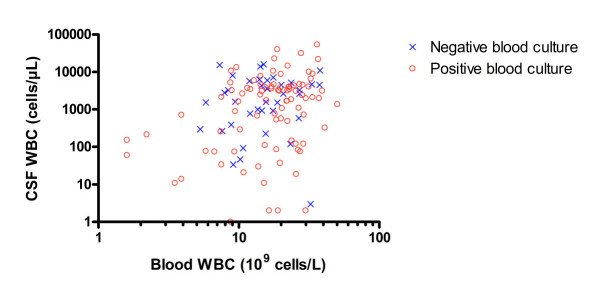
Correspondent CSF and blood WBC concentrations in patients with pneumococcal meningitis. Correlation between CSF and blood WBC: all patients (n = 127, rho = 0.234, P = 0.008), patients with a positive blood culture (n = 89, rho = 0.272, P = 0.01) and patients with a negative blood (n = 38, rho = 0.159, P = 0.34). No significant difference in CSF WBC between patients with a positive or a negative blood culture (P > 0.05).